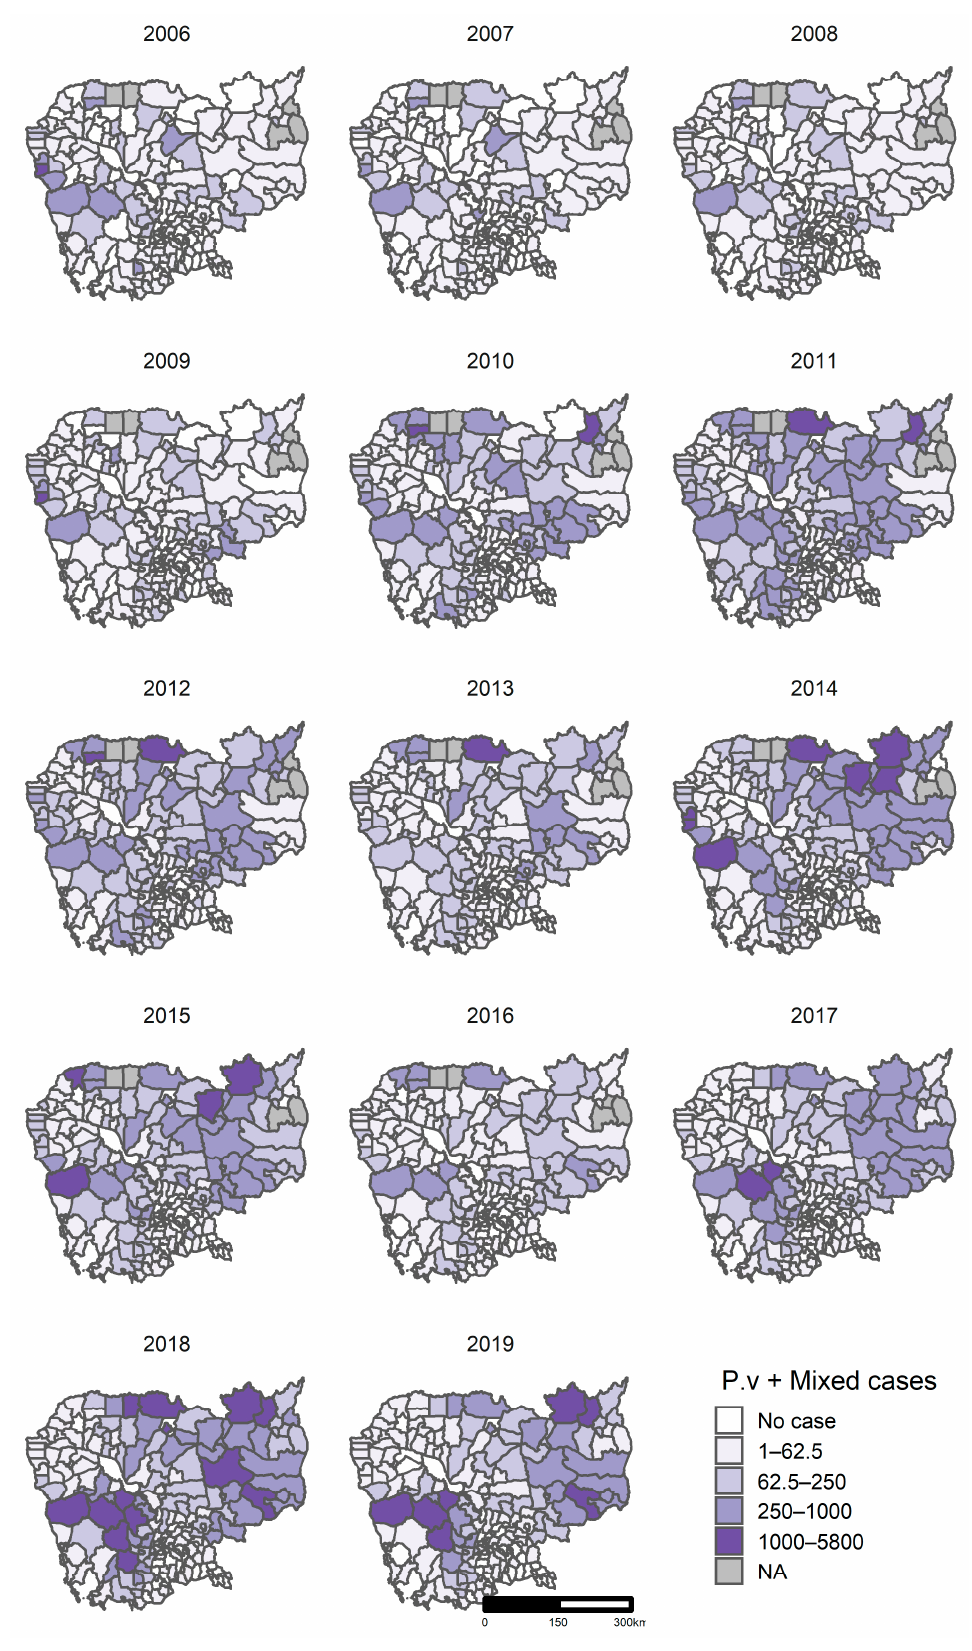
Figure 7. Confirmed P. vivax + Mixed cases by district, 2006–2019, Cambodia. Abbreviation: NA, not